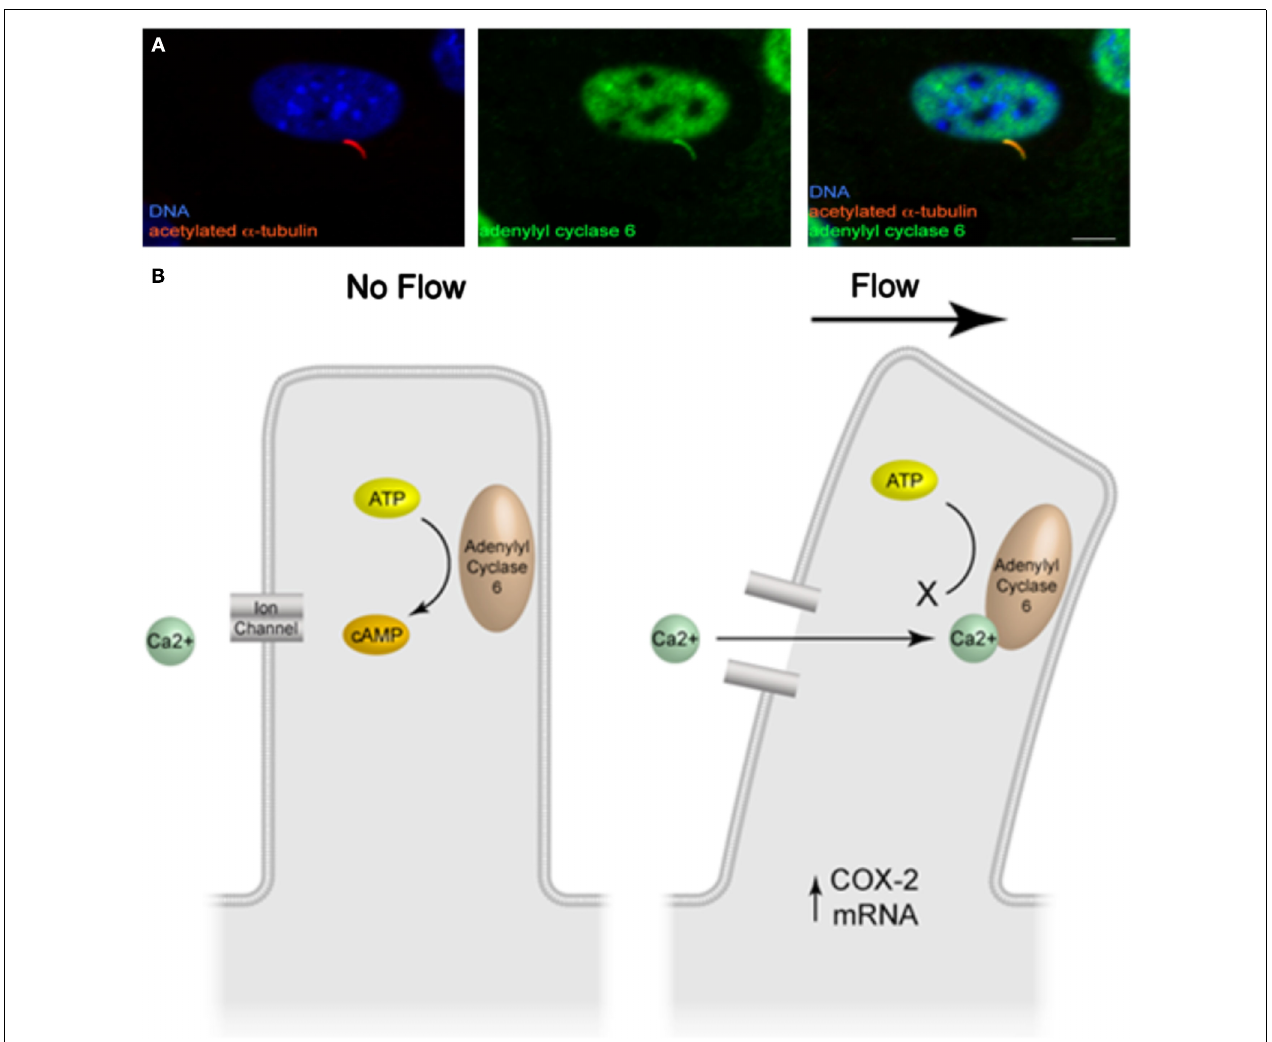
FIGURE 2 | (A) Immunofluorescence image of adenylyl cyclase 6 localization to the osteocyte primary cilium (adapted from Kwon et al., 2011). (B) Illustration of the molecular mechanism of cilia-mediated mechanosensing in bone.